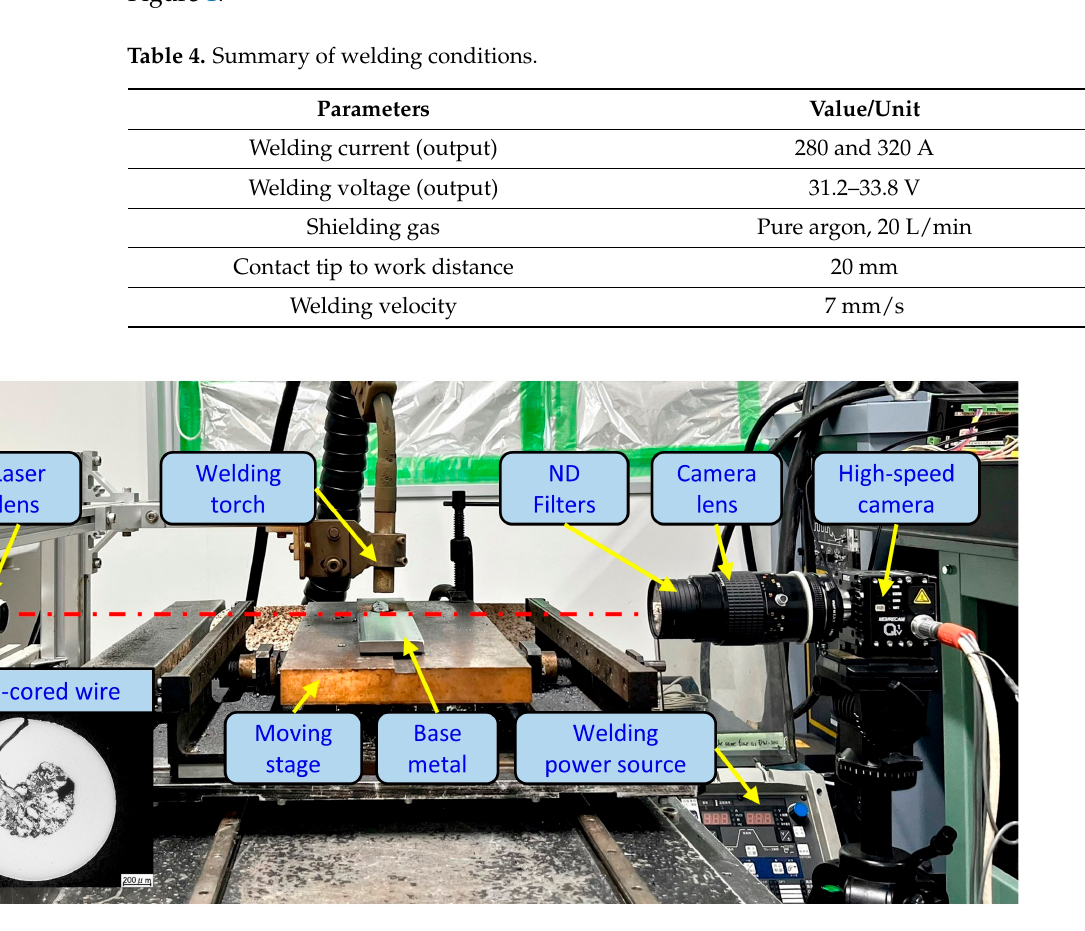
Figure 1. A photo of the experimental